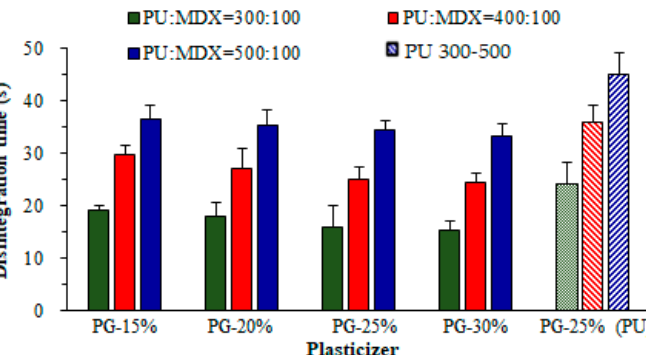
Figure 10. Influence of maltodextrin and propylene glycol amounts on the D-time of RZT-ODFs. Solid filled clustered columns represent; PUL:MTX = 300:100 (green), PUL:MTX = 400:100 (red), and PUL:MTX = 500:100 (blue), whereas pattern filled clustered columns represent only PU based formulations; PU = 300 (50% green), PU = 400 (downward diagonal red), and PU = 500 (upward diagonal). The common x -axis label shows the percentage of propylene glycol. Results are shown as average ± SD ( n = 6).